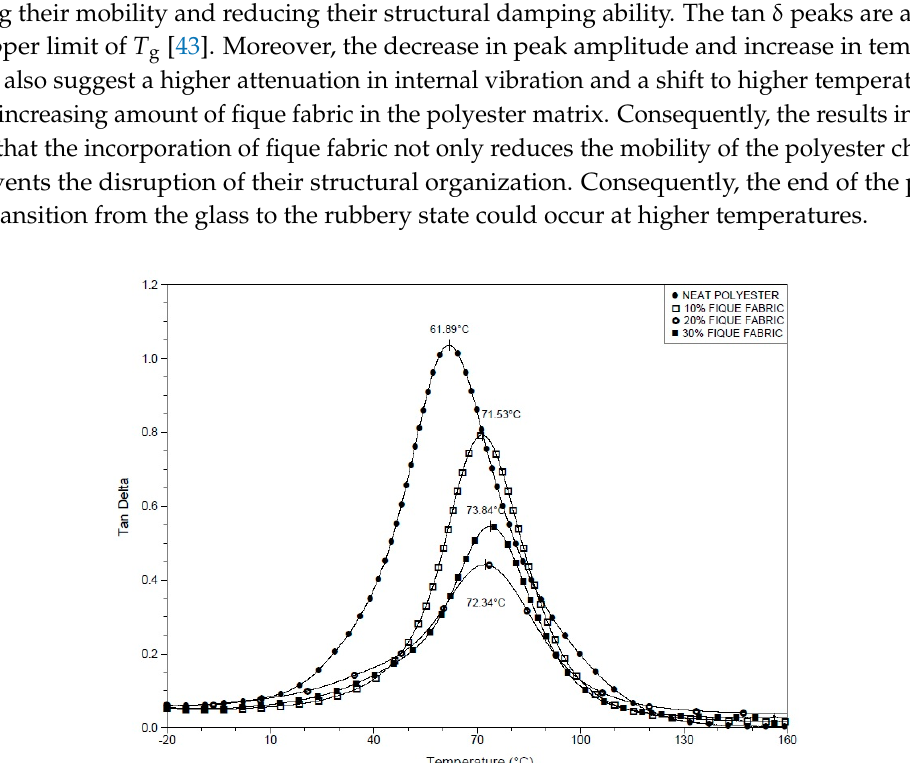
Figure 4. Loss modulus (E”) curves for the neat polyester resin and for the composites reinforced with fique fabric.